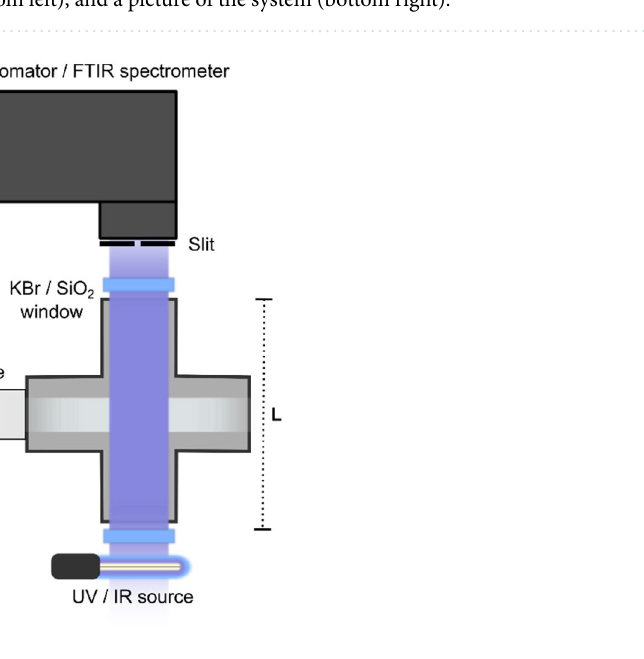
Figure 3. The same system was used to characterize the chemical composition (FTIR spectrometer and IR source) and the ozone concentration (V-INR monochromator and UV lamp) after the plasma